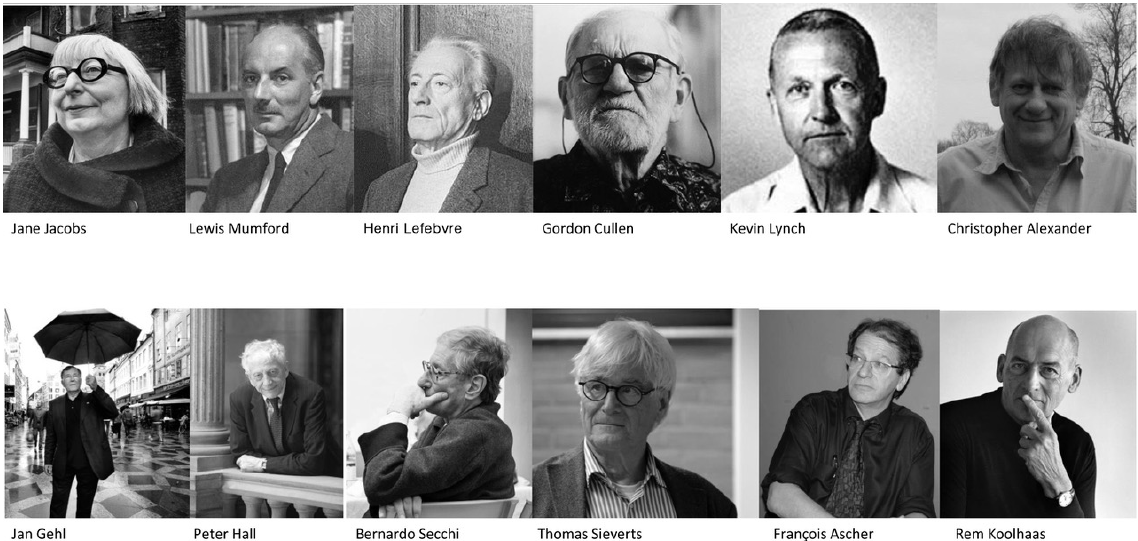
Figure 1. Asking the